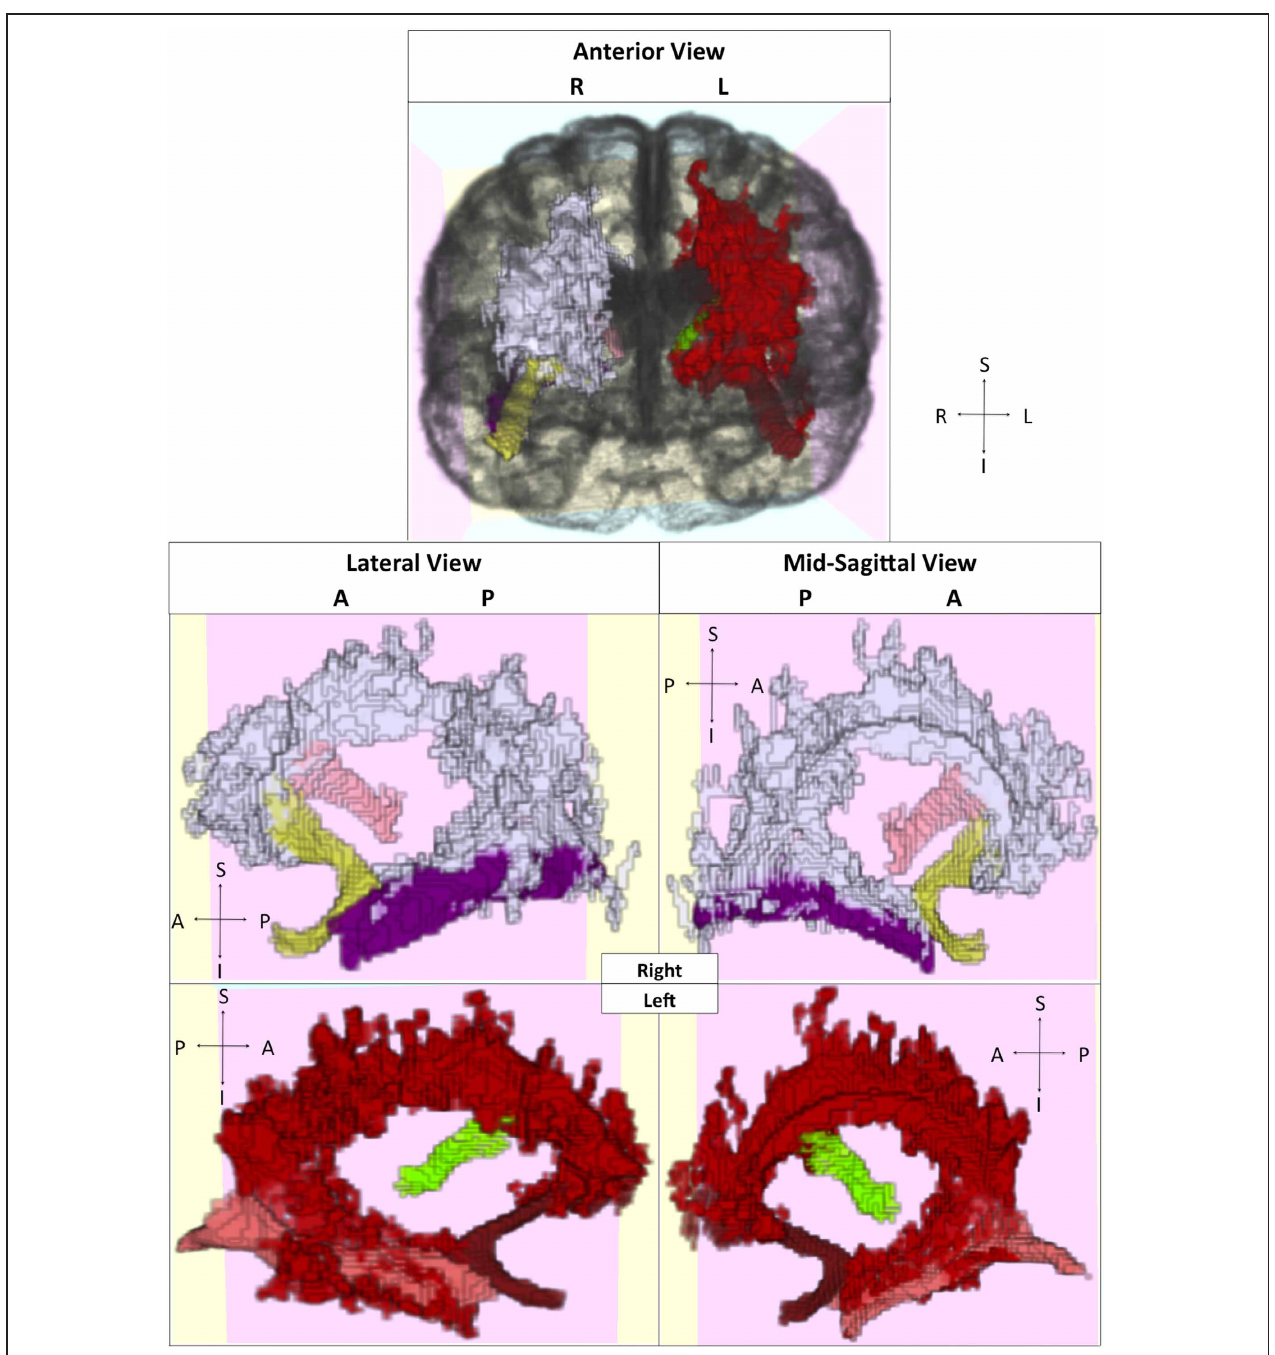
FIGURE 6 | Visualization of selected tracts passing through clusters. Clusters and tracts displayed in different colors and presented in multiple orientations. White: right hemisphere cluster; Yellow: right uncinate fasciculus; Light pink: right thalamus-middle frontal gyrus